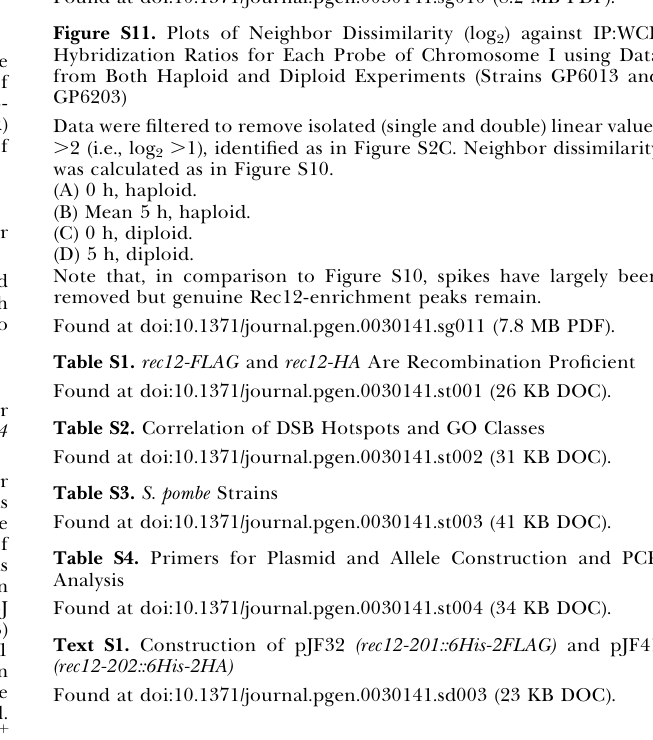
Figure S7. Rec12-DNA Linkages across the Entire S. pombe Genome